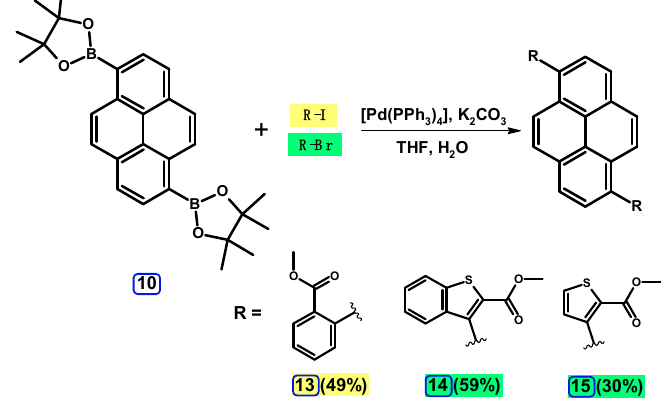
Scheme 6. The Suzuki-Miyaura coupling reactions of 10 [10,42].